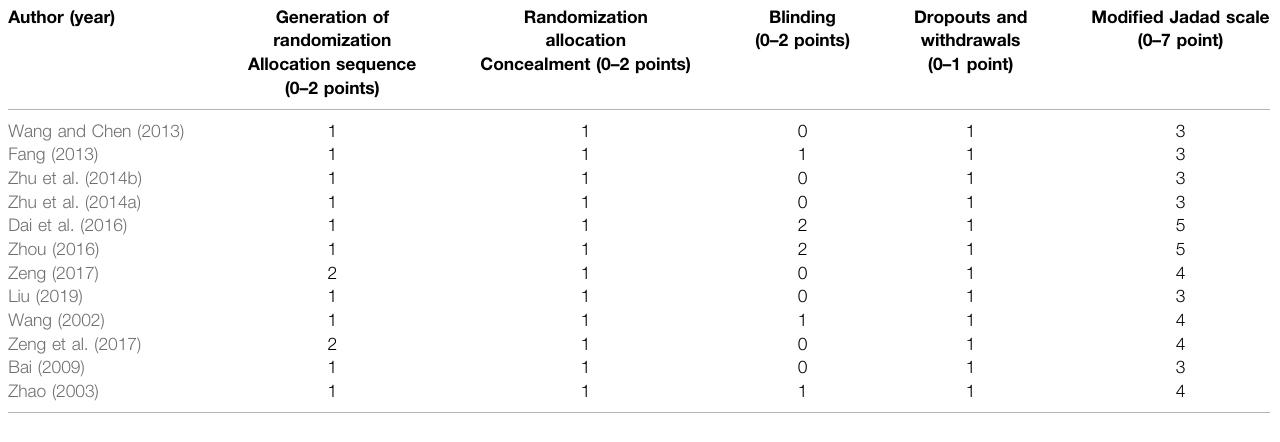
TABLE 4 | Modi fi ed Jadad scale of included trials.